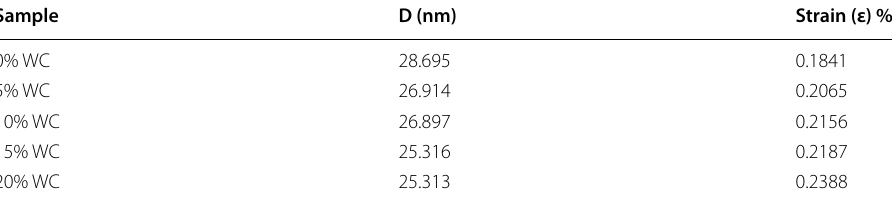
(WC) ( x 0–20 wt%) HEA 1-x x =